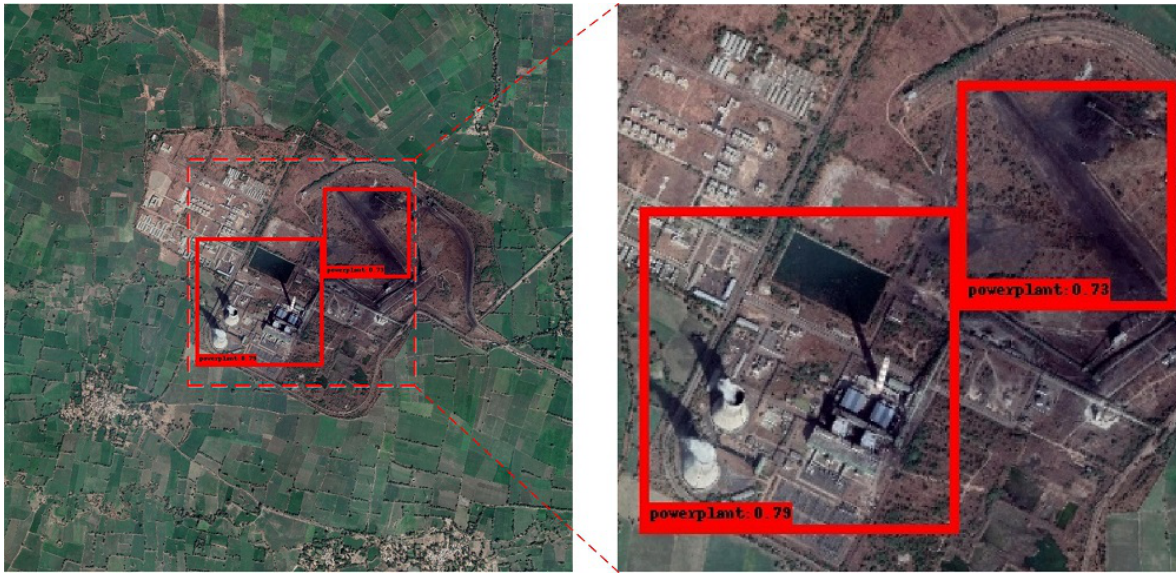
Figure 7. TPP test results on a remote sensing image which covers 2 km × 2 km. The detected category name and confidence are marked in the lower left corner in predicted bounding